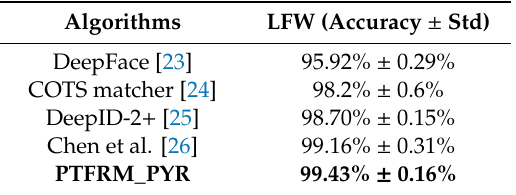
Table 1. Accuracy of related algorithms on the LFW test set.